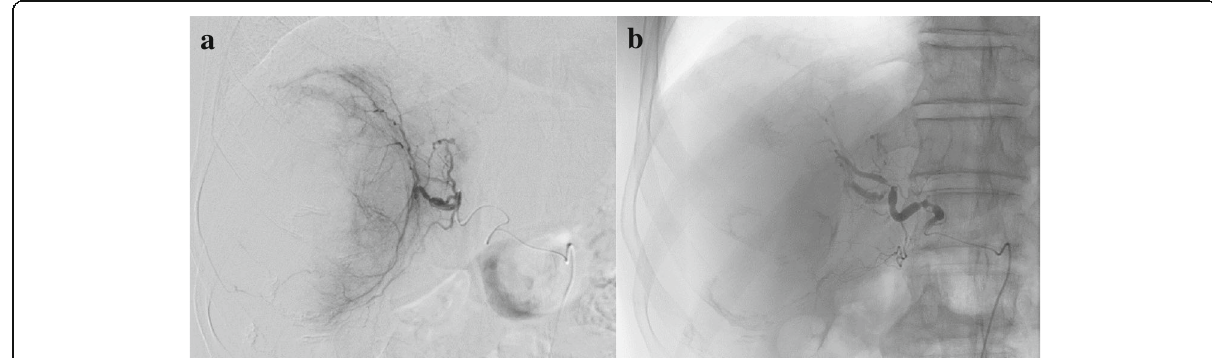
Fig. 2 Transcatheter arterial embolization was performed. Selective hepatic angiogram revealed that the branches of the right posterior hepatic artery were stretching with peripheral enhancement of the liver with no extravasation ( a ). The right posterior hepatic artery was embolized with a